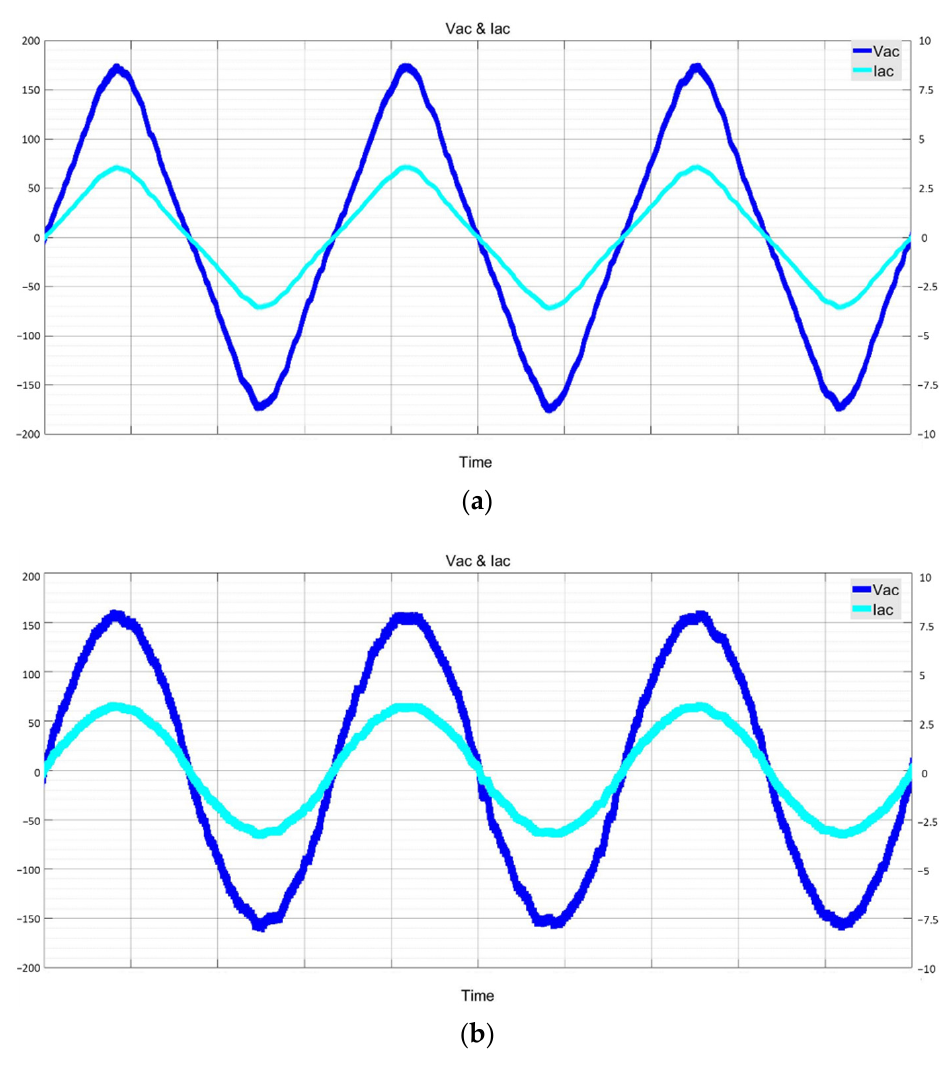
Figure 15. The simulation results (250 W) of the voltage and current output waveforms when using ( a ) the traditional SPWM control and ( b ) modified SPWM control.